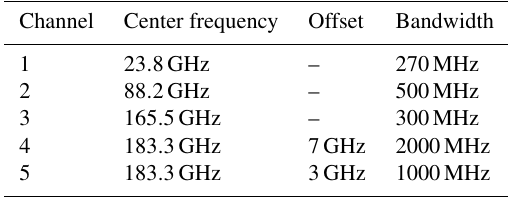
Table 1. Observation channels used for the synthetic retrieval of column water